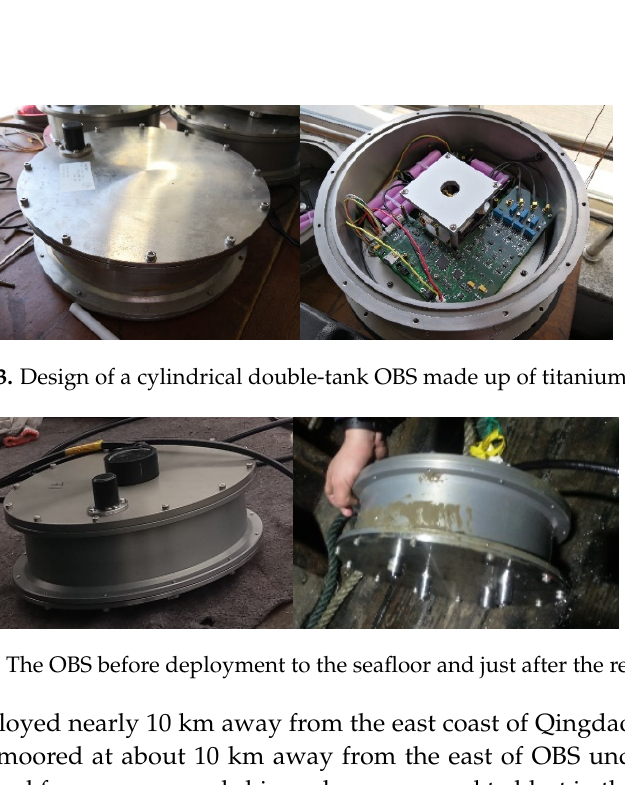
Figure 34. The OBS before deployment to the seafloor and just after the recovery.